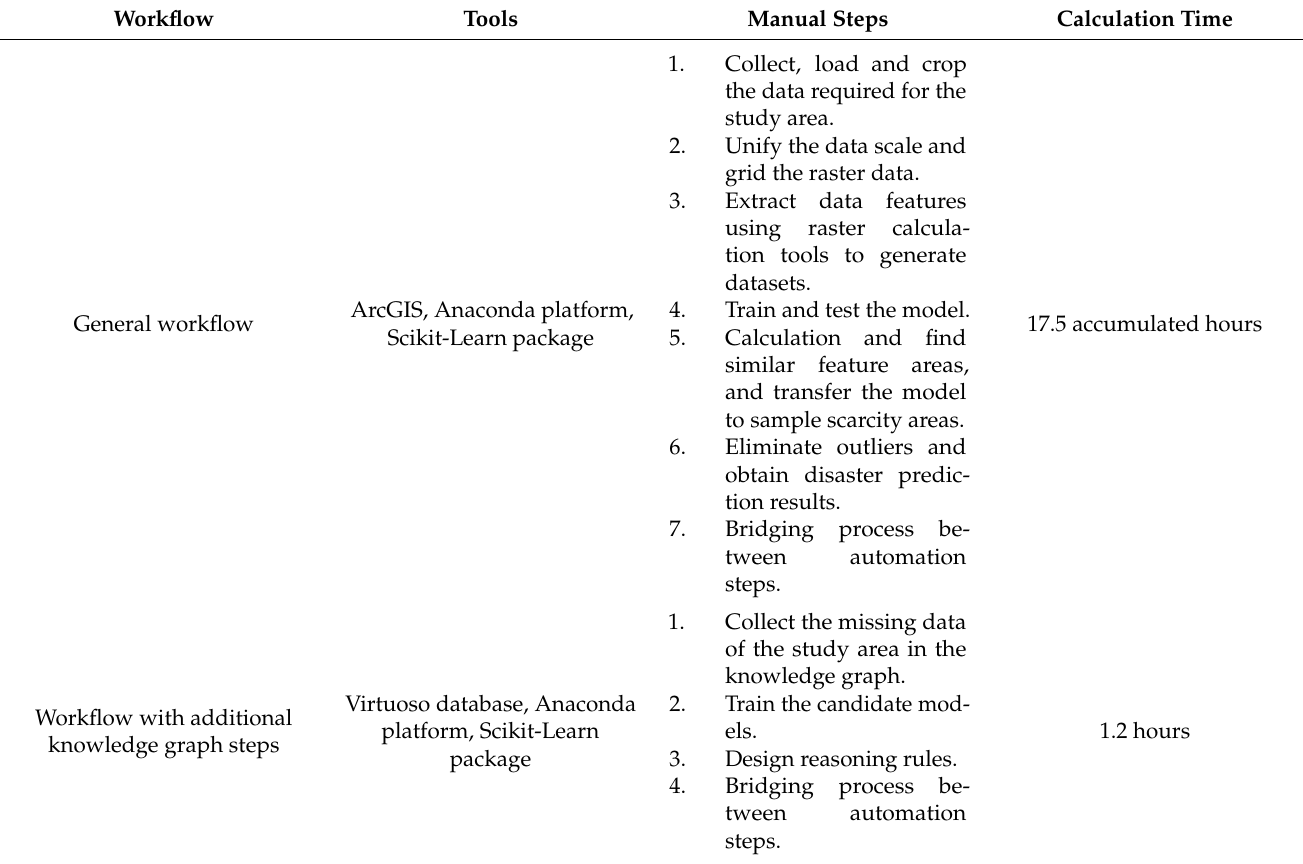
Table 4. Effectiveness comparison of general workflow and workflow with additional knowledge graph